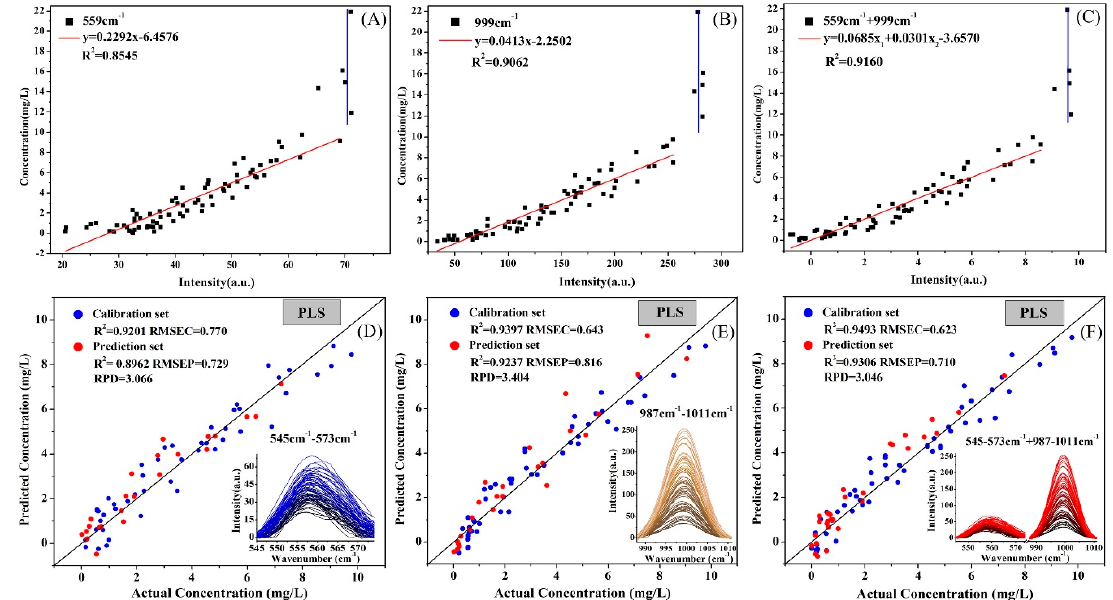
Figure 7. Quantitative detection models of deltamethrin in Corydalis . Linear regression equation between peak intensity and deltamethrin content in Corydalis : ( A ) 559 cm − 1 ; ( B ) 999 cm − 1 ; ( C ) 559 cm − 1 + 9 99 cm − 1 . Partial least squares regression (PLSR) model based on spectral data of characteristic peak bands and deltamethrin content: ( D ) 545~573 cm − 1 ; ( E ) 987~1011 cm − 1 ; ( F ) (545~573 cm − 1 ) + (987~1011 cm − 1 ).